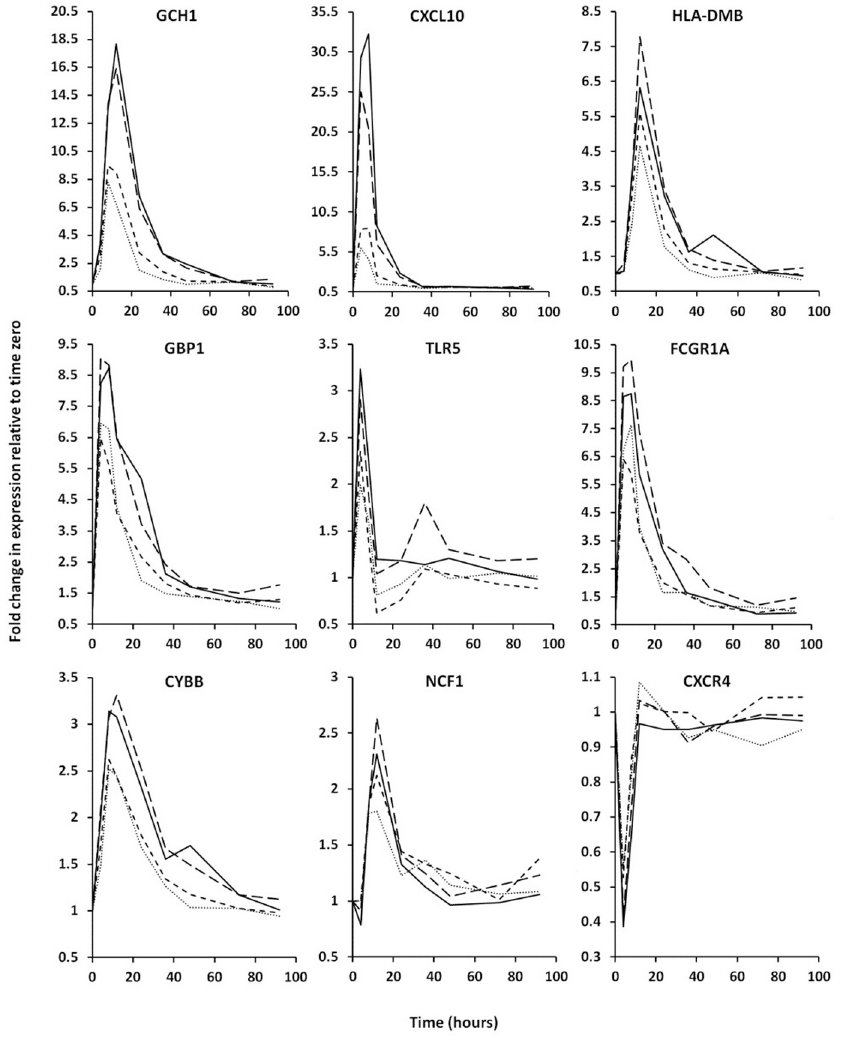
Fig 4. Examples of gene expression changes in response to IFN- γ administration. The fold changes relative to expression levels just prior to IFN- γ administration (time 0) are plotted against the various times at which blood was drawn. The selected genes are discussed in more detail throughout the manuscript. The doses of IFN- γ causing expression changes are indicated by line style (10 μ g/m 2 , dots; 25 μ g/m 2 , short dashes; 50 μ g/m 2 , long dashes; 100 μ g/m 2 , solid line). Raw expression data from individual genes are shown in S1